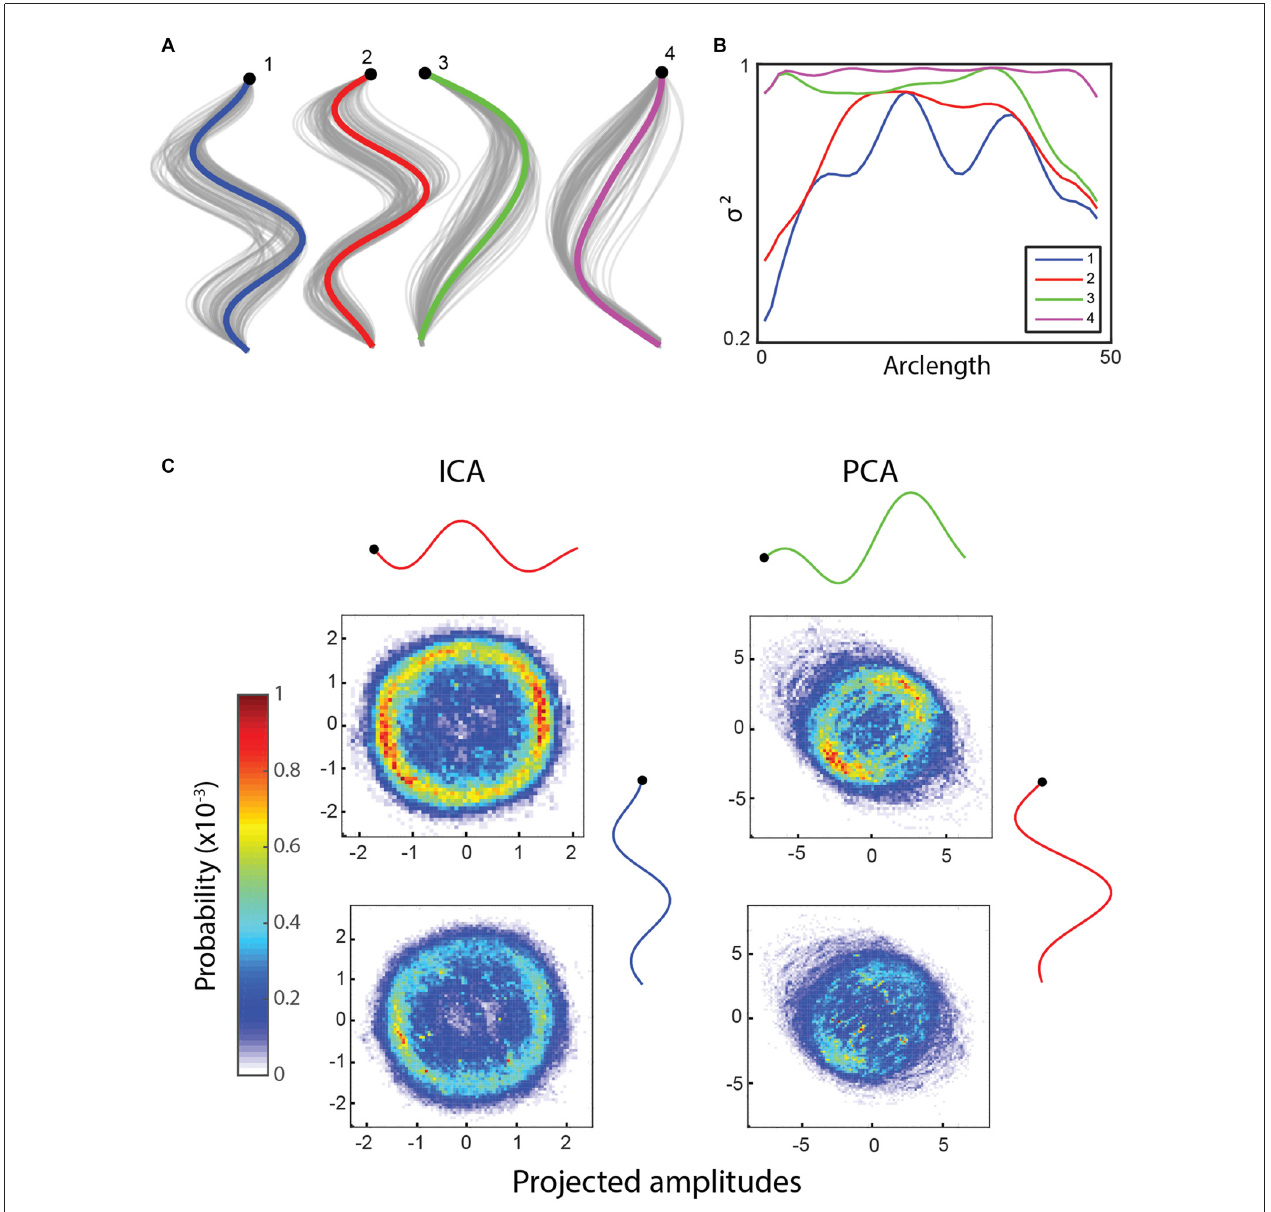
FIGURE 2 | (A) Independent component analysis (ICA) returns four basis shapes that explain 97.6% of the variance in the dataset. The graph shows an x - y coordinate representation of the modes with the resampled basis shapes in gray. (B) The fraction of the variance explained along the worm by including an increasing number of basis shapes suggests that the modes can each explain a different part of the worm well. (C) Bivariate histograms for the amplitudes of basis shapes (wild type worm, 15 min, frame rate: 30 Hz). Top row: forward locomotion only, bottom row: all data. Basis shapes 1 and 2 from ICA form a ring in both cases (especially clear when only the forward locomotion is counted), suggesting an oscillatory behavior between them. Similarly, two basis shapes from principal component analysis (PCA) are known to explain an oscillatory behavior, but they also include other information, as evidenced by a lack of clear, continuous ring in their histograms.